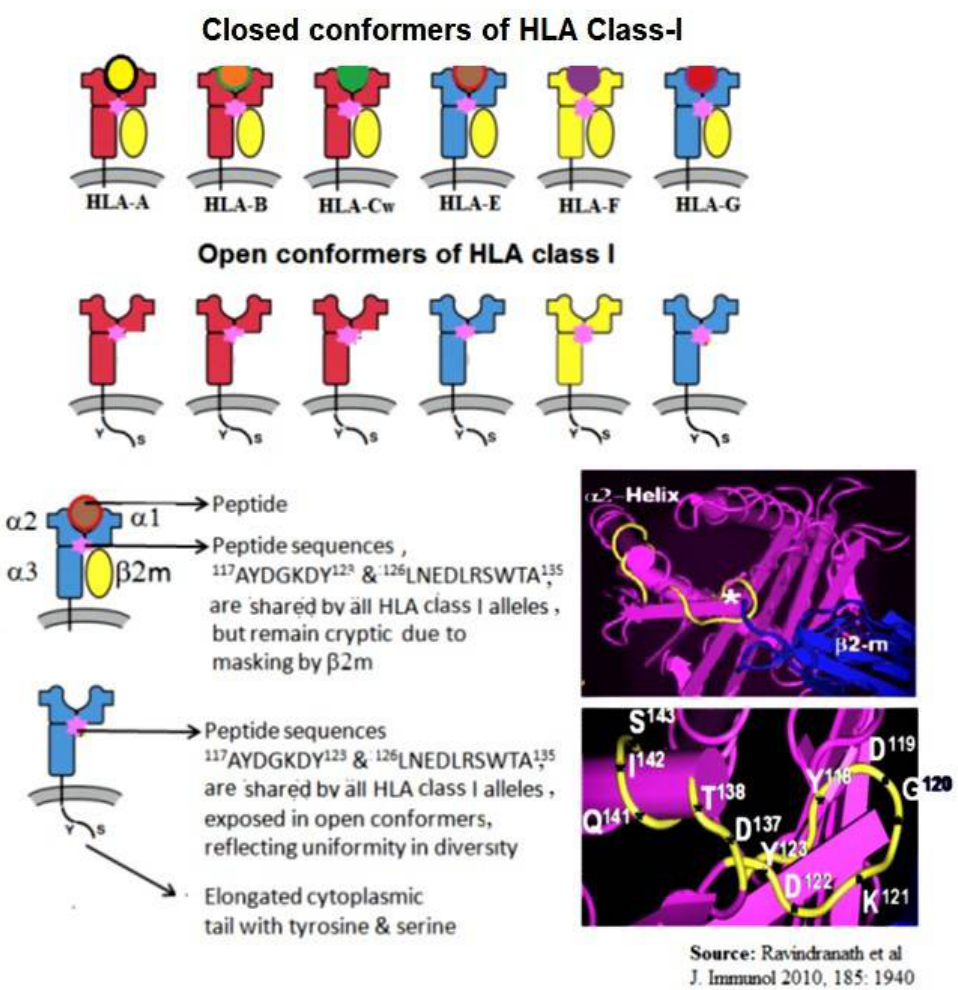
Figure 2. Diagrammatic illustration of six isoforms of HLA class I molecules. The upper row shows the structures of intact, trimeric, closed conformers (CCs) of HLA. Note the shortened cytoplasmic tail. The lower row shows monomeric HLA-I (open conforms OCs). OCs of HLA-I expose epitopes masked by β2m. These epitopes, particularly 117 AYDGKDY 123 and 126 LNEDLRSWTA 135 , are found in almost all alleles of the six isoforms of HLA.